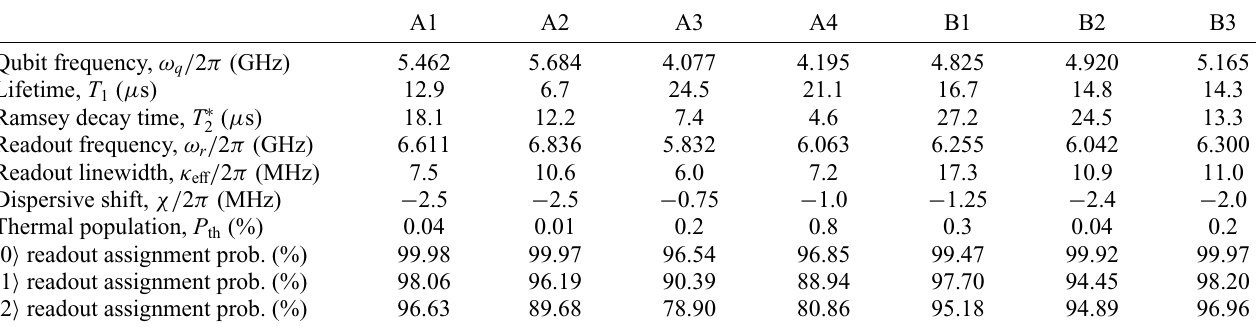
TABLE I. Measured parameters of the seven qubits.